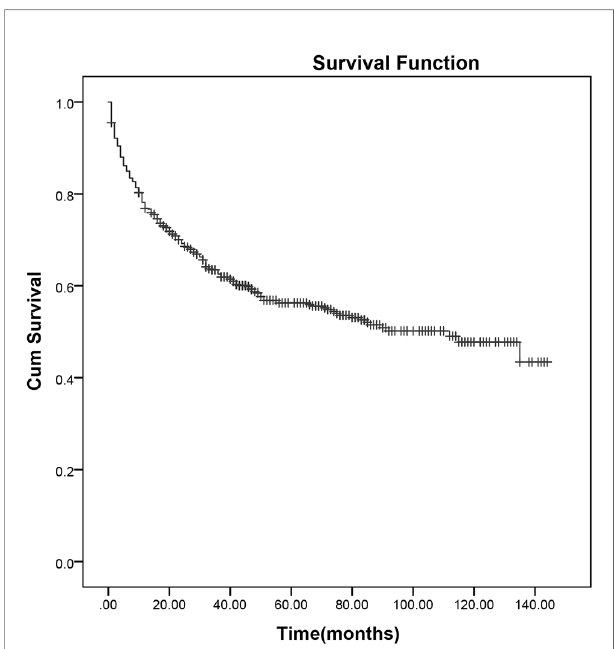
FIGURE 1 | Survival curves of 533 patients with extranodal natural killer/T- cell